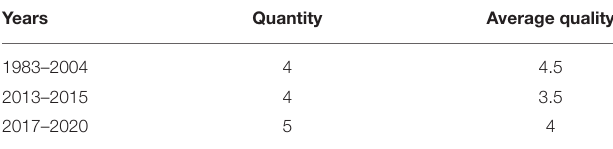
TABLE 3 | Quality mean values by year.